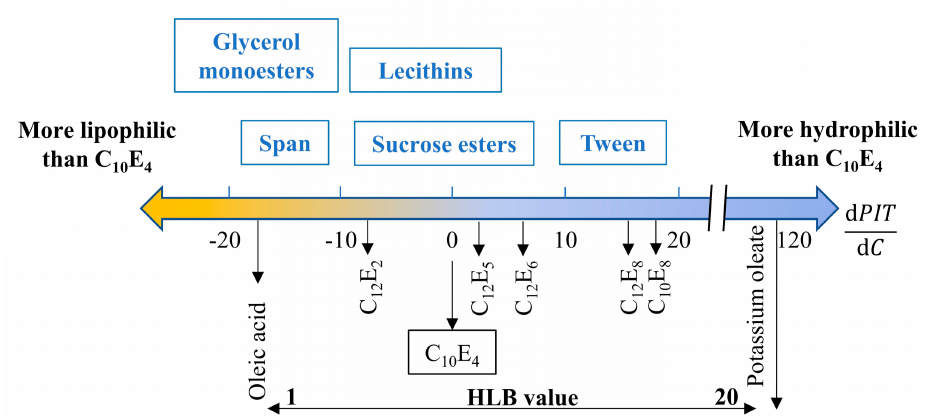
Figure 7. Summary of PIT point variation by adding a second surfactant in a C 10 E 4 /Octane/Water system (Reproduced with permission from Ref. [99]. Copyright 2014